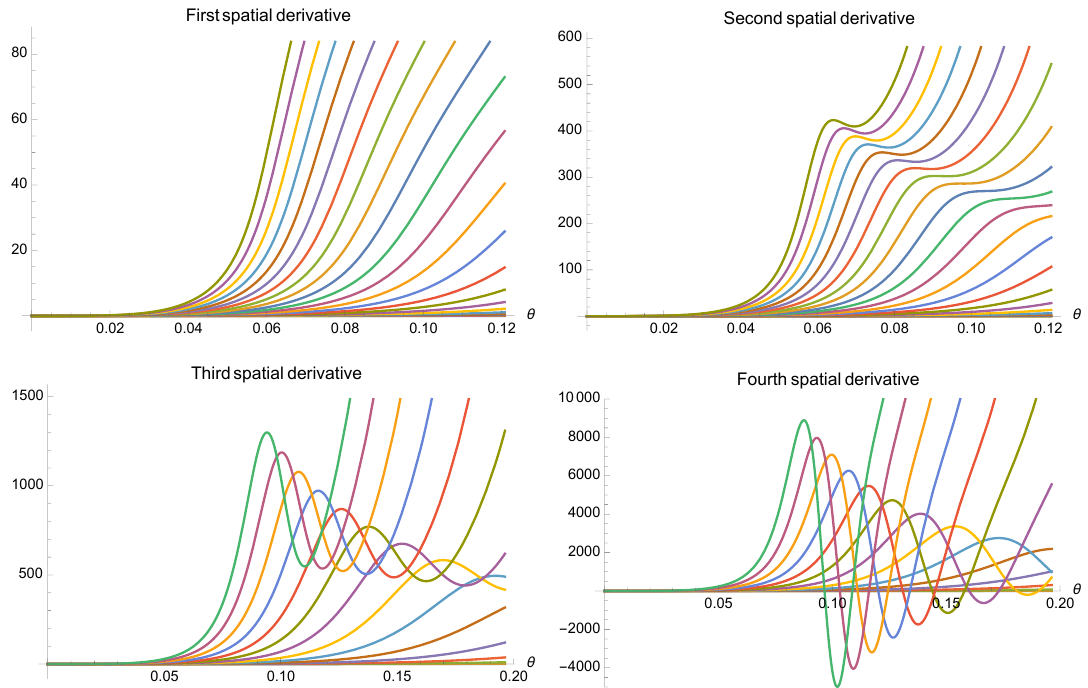
Figure 3 . (top) The (cid:12)rst and the second spatial derivatives of the sandwiched R(cid:19)enyi divergence for n = 2 to n = 26 are non-negative and consistent with monotonicity and our proof. (bottom) The third and the fourth spatial derivatives are plotted for n = 2 to n = 16. For large enough n , the fourth derivative becomes